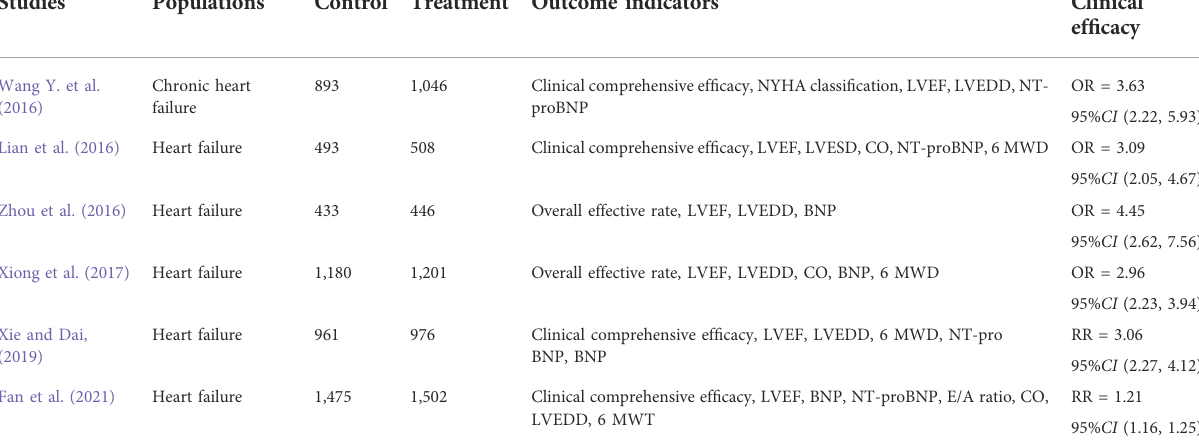
TABLE 4 Meta-analyse and systematic reviews of YiQiFuMai injection in the treatment of heart